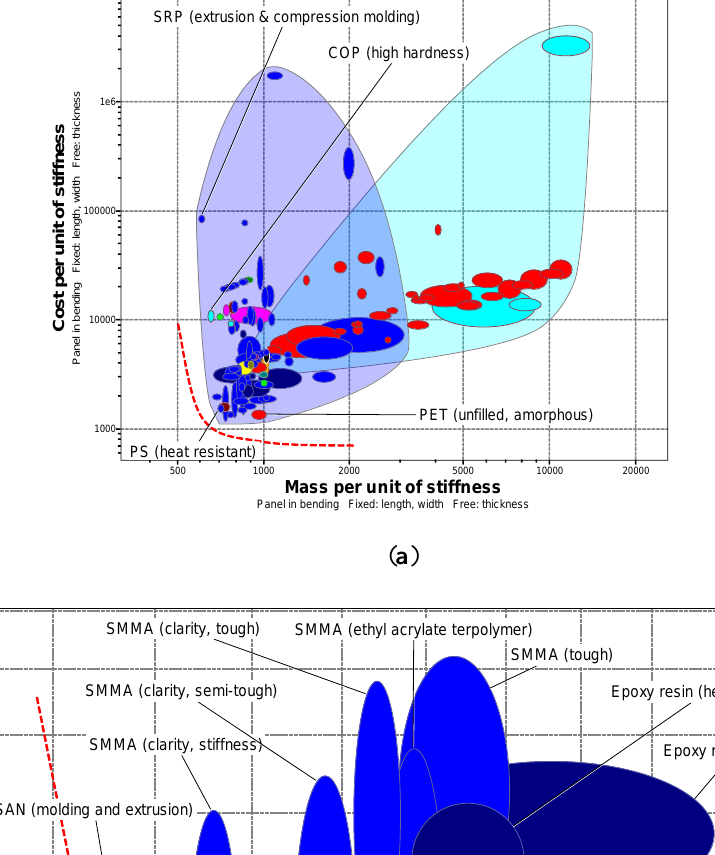
𝑓− 1 3 𝐶 𝑚 ∙ 𝜌 ∙ 𝐸 of bent panel were chosen as the axes for Ashby chart (Figure 3a). Here ρ is density, E f is flexural modulus and C m is the price per unit mass. Left bottom corner is the region of interest corresponding to light cheap material solutions and the set of 16 candidate materials in that region is depicted in Figure 3b. Red dashed line represents the envelope for best weight (SAN) and cost (SMMA) solutions.